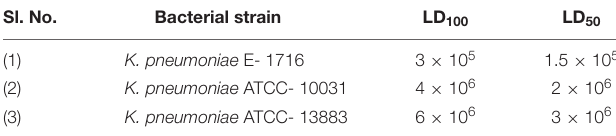
TABLE 3 | Lethal dose determination for various K. pneumoniae strains in BALB/c mouse model. Sl. No.